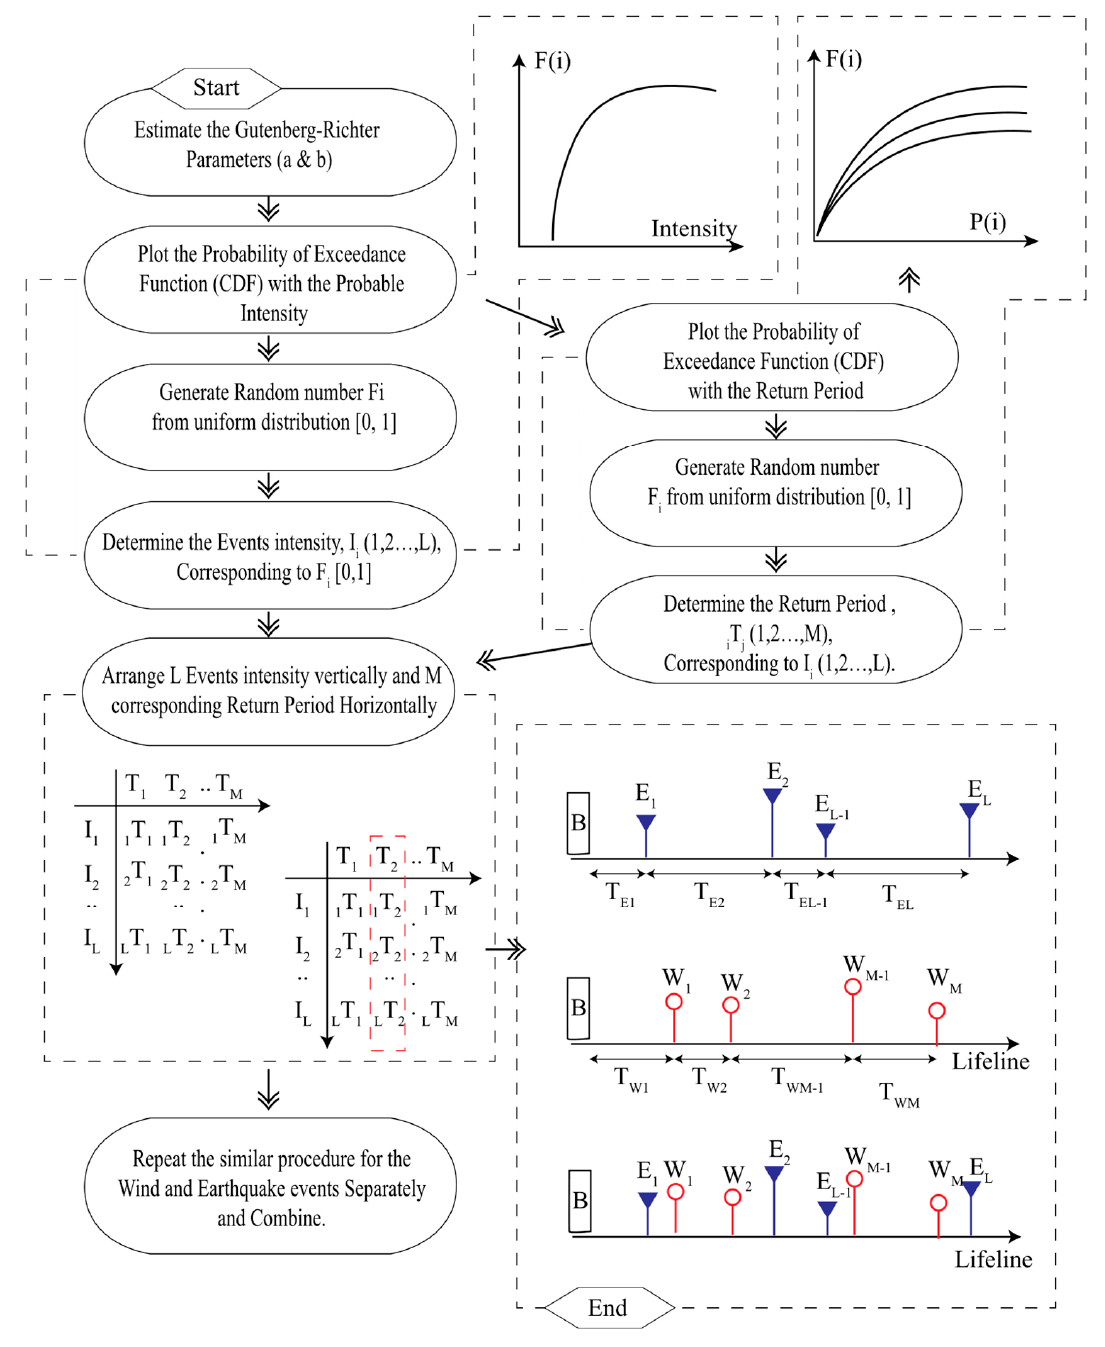
Figure 9. Flowchart of probable earthquake and wind events generation in the project lifetime.